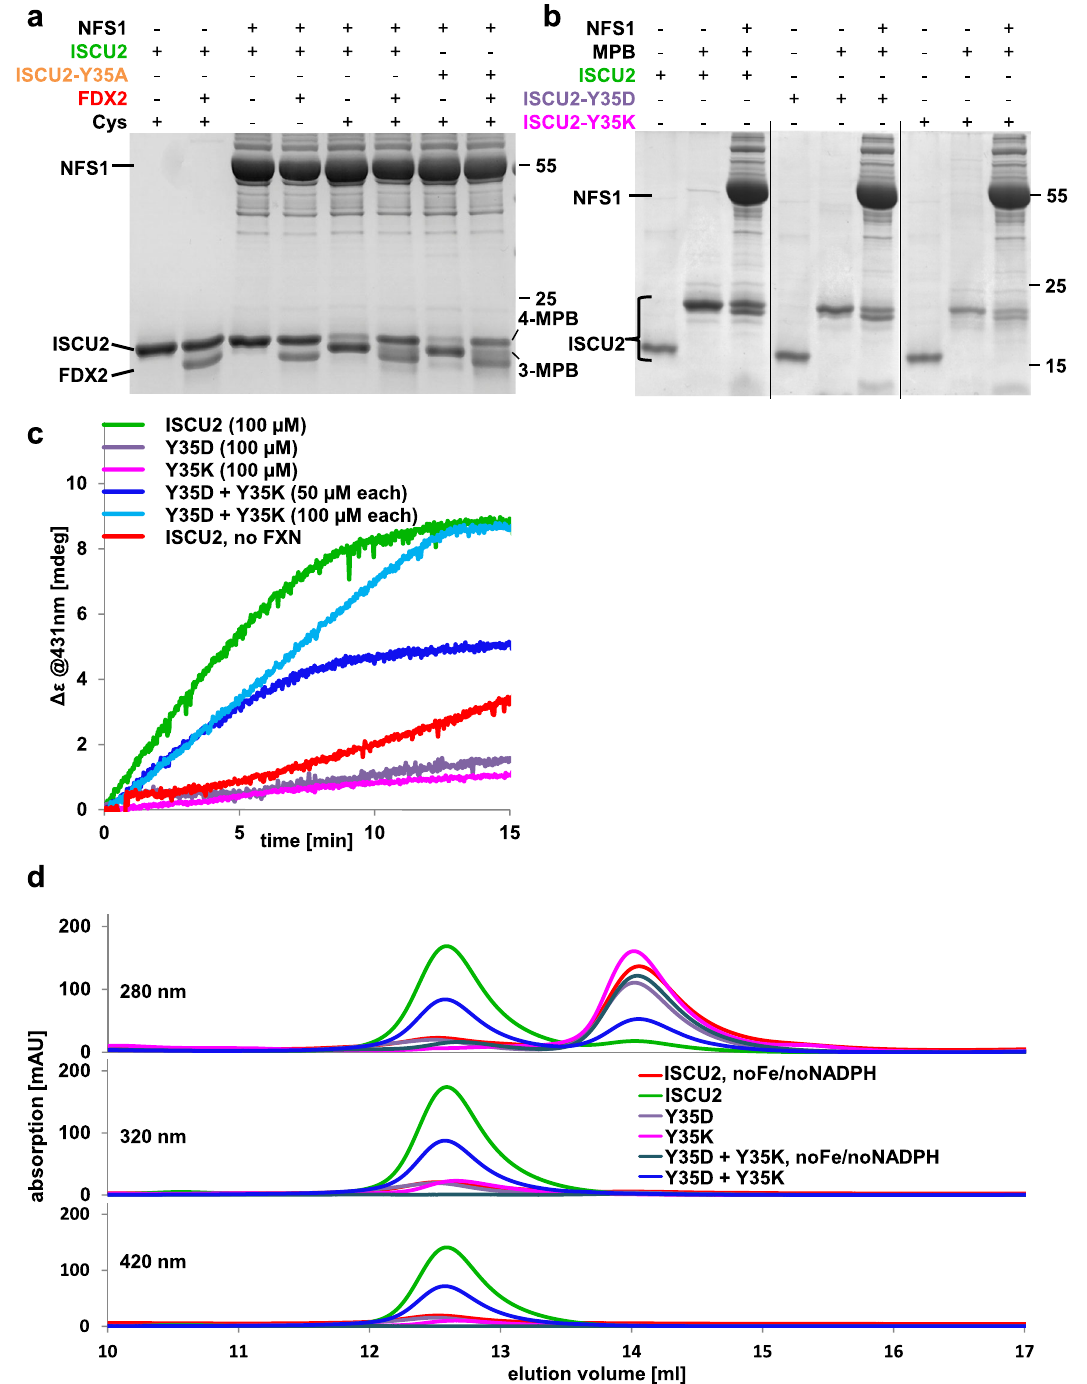
Fig. 5 The N-terminal Tyr35 of ISCU2 is not required for persul fi de reduction, yet essential for [2Fe-2S] cluster synthesis and ISCU2 dimerization. a Reduction of ISCU2-Y35A-bound persul fi de by FDX2 assayed as described in Fig. 3c (see also Supplementary Fig. 7a). Reactions without (NIA) 2 or cysteine served as controls (lanes 1 + 2 and 3 + 4, respectively). The re-appearance of fourfold MPB-labeled ISCU2 in lanes 6 and 8 indicates ef fi cient persul fi de reduction by FDX2. The experiment was repeated twice with similar outcome. b Persul fi de transfer from NFS1 onto wild-type ISCU2 as well as ISCU2-Y35D or ISCU2-Y35K mutant proteins. Reactions without (NIA) 2 plus and minus MPB served as controls. The experiment was repeated at least three times with similar outcome. c Enzymatic reconstitution (cf. Fig. 3d) of wild-type ISCU2 or the ISCU2 mutant proteins Y35D, Y35K, and the mixture of Y35D and Y35K as indicated. d Anaerobic analytical size-exclusion chromatography (aSEC) of enzymatically reconstituted ISCU2 and variants (color coding as in b ). The majority of ISCU2 and ca. 50% of the Y35D + Y35K mixture form dimers that carry a [2Fe-2S] cluster as indicated by absorption at 320 nm and 420 nm and CD spectrum (Supplementary Fig. 9a). In contrast, ISCU2-Y35D and ISCU2-Y35K eluted as monomers like apo-ISCU2, and showed no absorbance at 320 nm or 420 nm indicating that no Fe/S cluster was formed. Source Data are provided as a Source Data fi le.